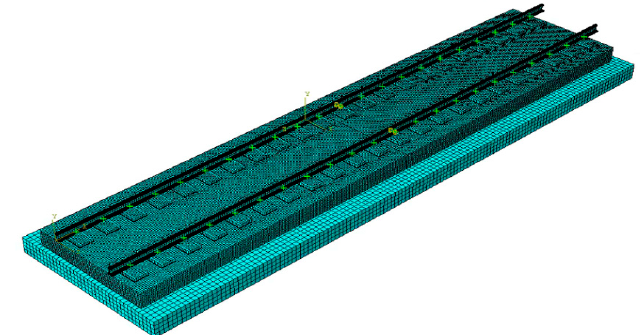
Figure 21. LVT finite element model with two slabs connected.